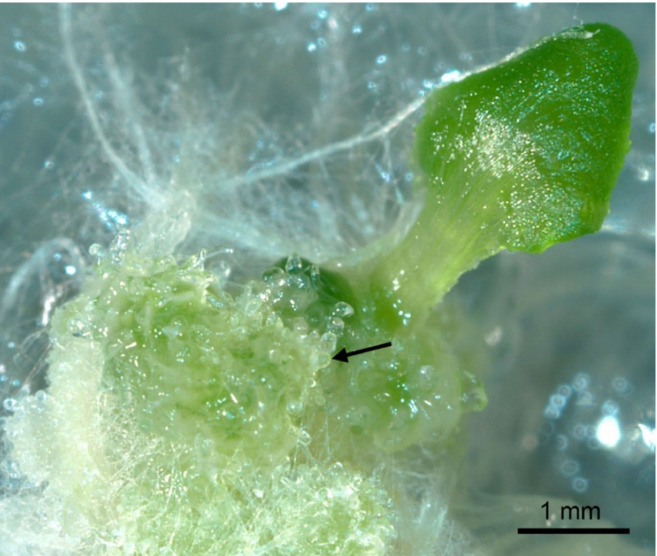
Figure 3. Spontaneous formation of embryo-like structures in T2 generation of Arabidopsis lec1- 1 PmLEC1 seedling containing the Douglas-fir PmLEC1 transgene. T2 lec1-1 PmLEC1 seeds germinated on kanamycin-containing MS medium and produced roots and cotyledons. Multiple embryo-like structures emerged from one cotyledon, whereas the other cotyledon remained morphologically normal. Several of these structures resembled late globular stage embryos